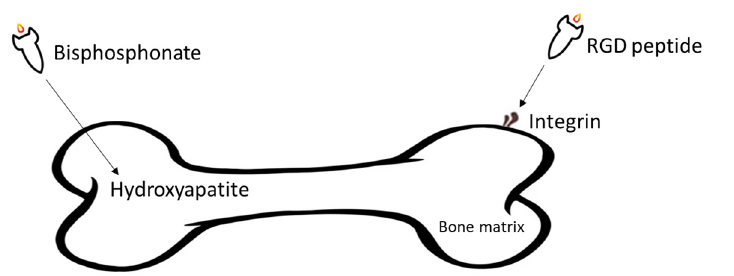
Figure 3. Overall illustration of targeting agents utilised in the development of DDSs aiming at treating BC bone metastasis. treating BC bone